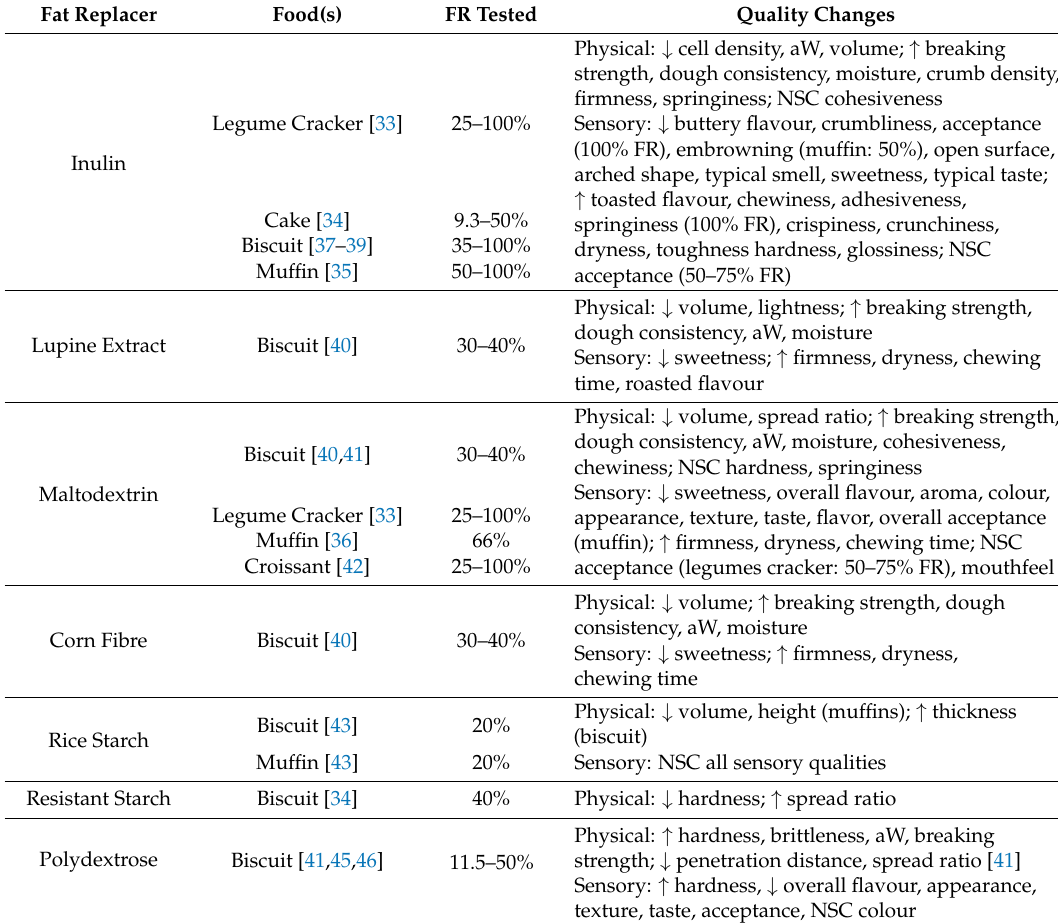
Table 1. Summary of quality changes of complex carbohydrate fat replacers in baked food